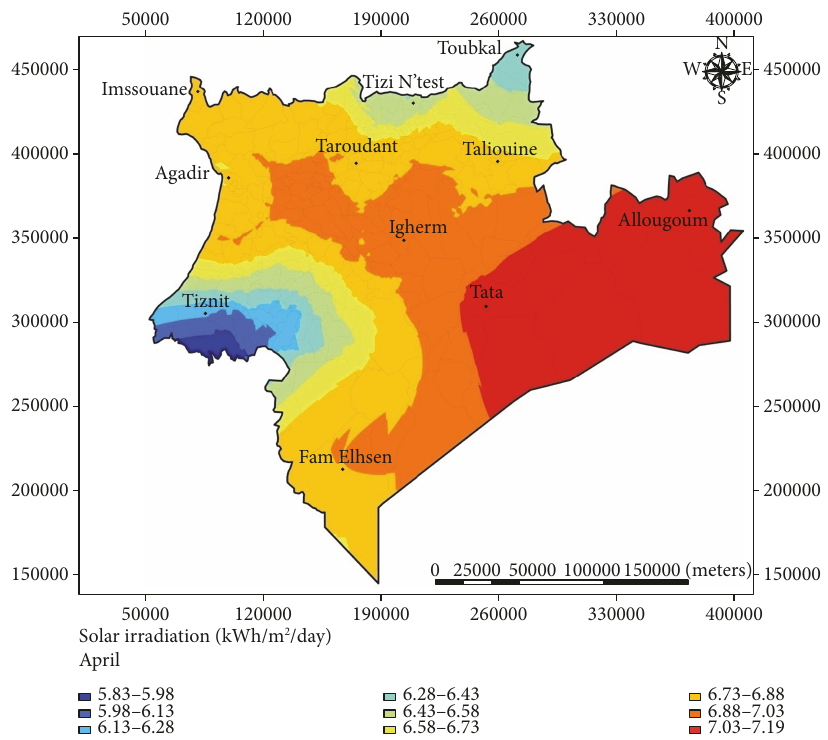
Figure 12: Solar energy potential map of the Souss-Massa area for the month of April as estimated by the ANN and designed with the Kriging interpolation